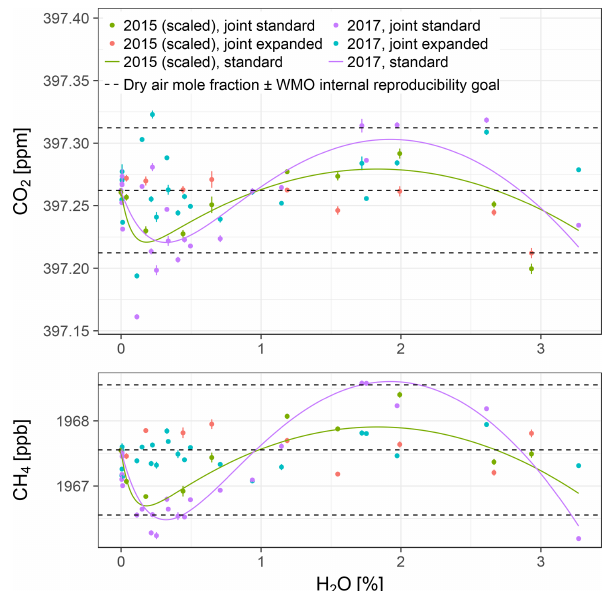
Figure 8. Water-corrected dry air mole fractions from the two ex- periments with Picarro no. 5. The data from the 2015 experiment have been scaled up to match the mole fractions measured in dry air in the 2017 experiment. The points are based on model fits to data from both experiments jointly (error bars: lower bounds of un- certainty; see Sect. S3), while the solid lines show differences be- tween the standard and expanded water correction models fitted to data from the 2015 and the 2017 experiments individually, offset by the mole fractions measured in dry air in the 2017 experiment. The dashed lines are the same as in Fig.